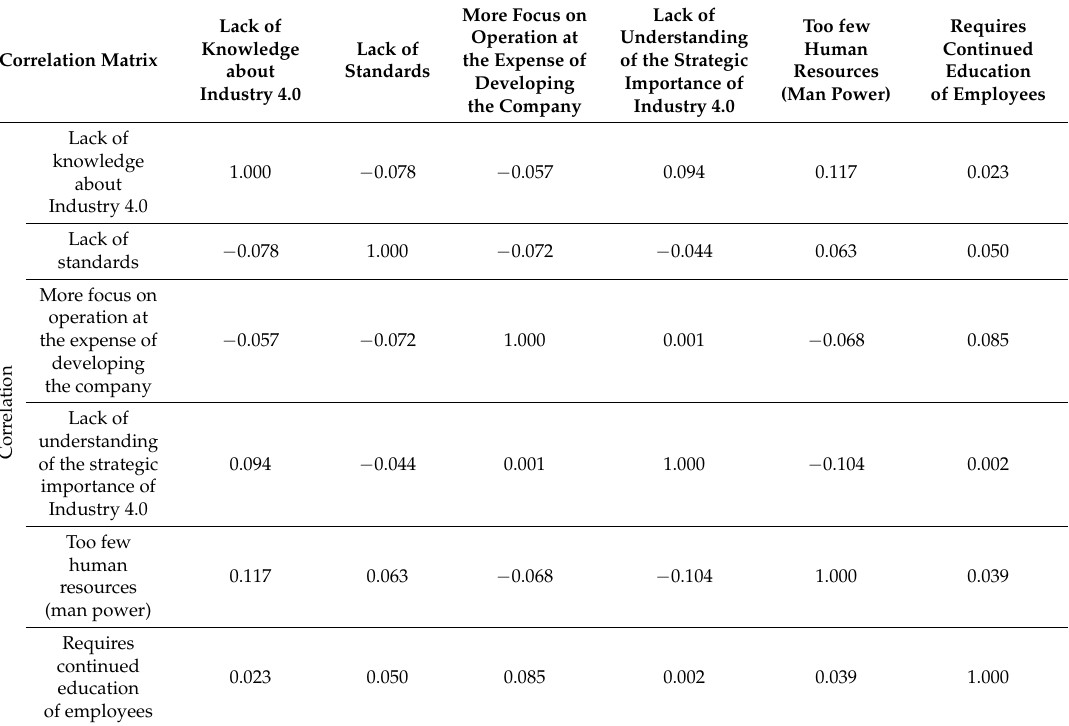
Table 8. Matrix of correlation coefficients between the 6 variables analyzed.